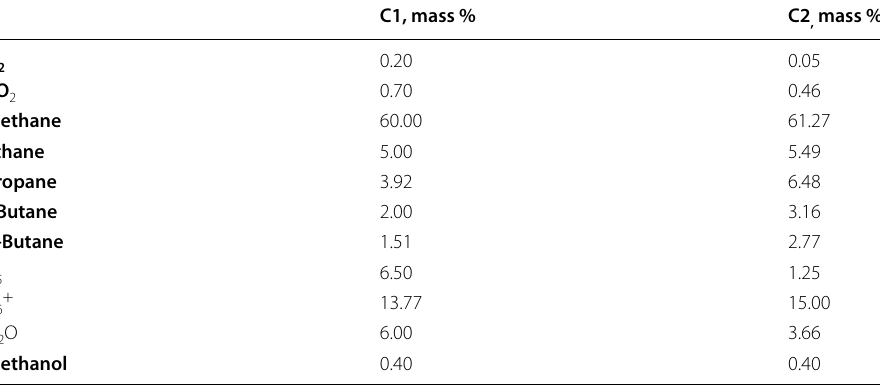
Table 2 Feed compositions of different wells (C1 and C2) of natural